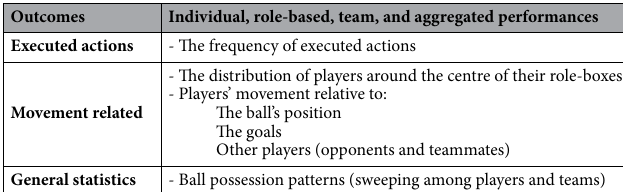
Table 3. A list of the selected outcome space.